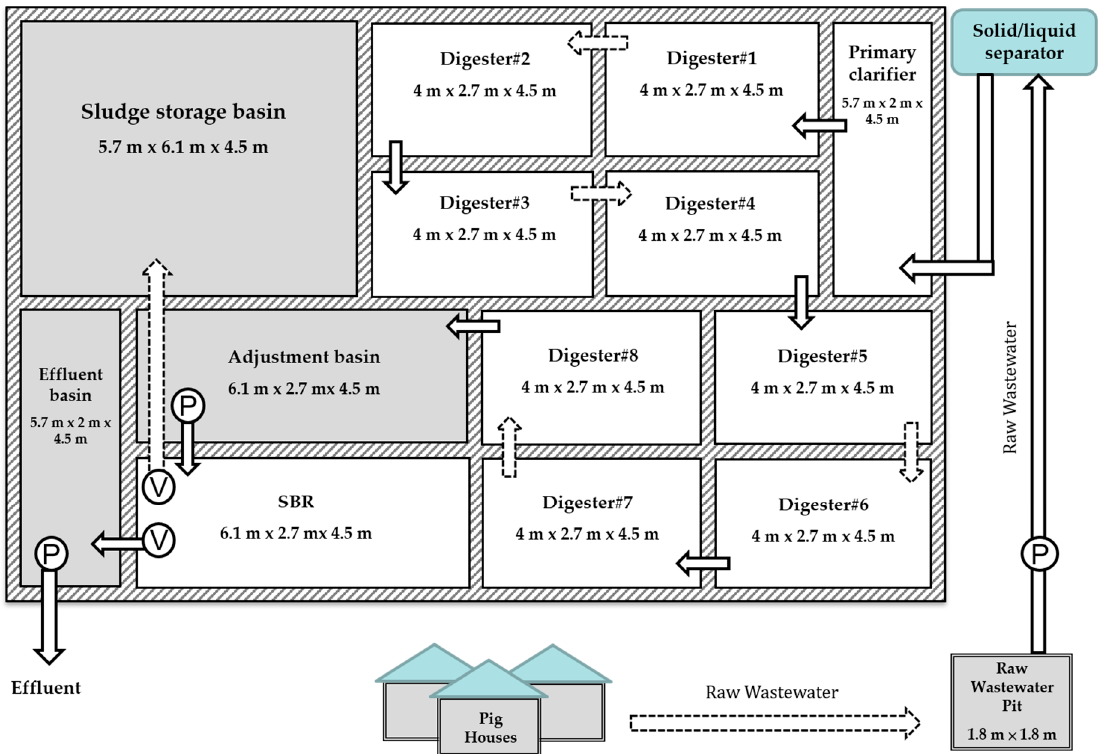
Figure 1. Design of the piggery wastewater treatment on the farm. The areas with grey color were the underground basins, and the white areas were the vertical basins above ground. P: water pump; V: motor-operated valve.